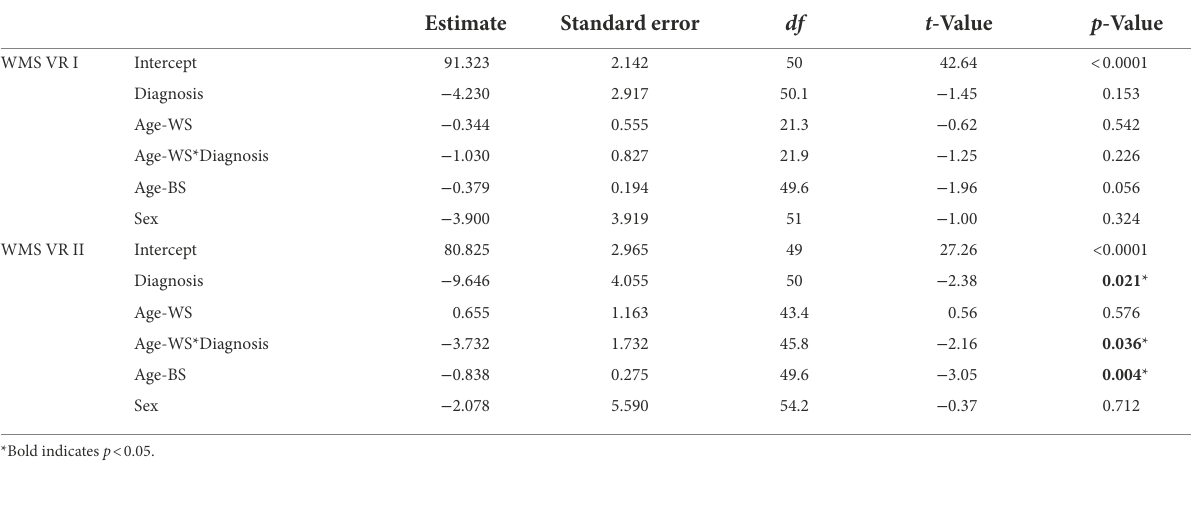
TABLE 2 Fixed effect estimates for longitudinal models of short-term and long-term visual memory.